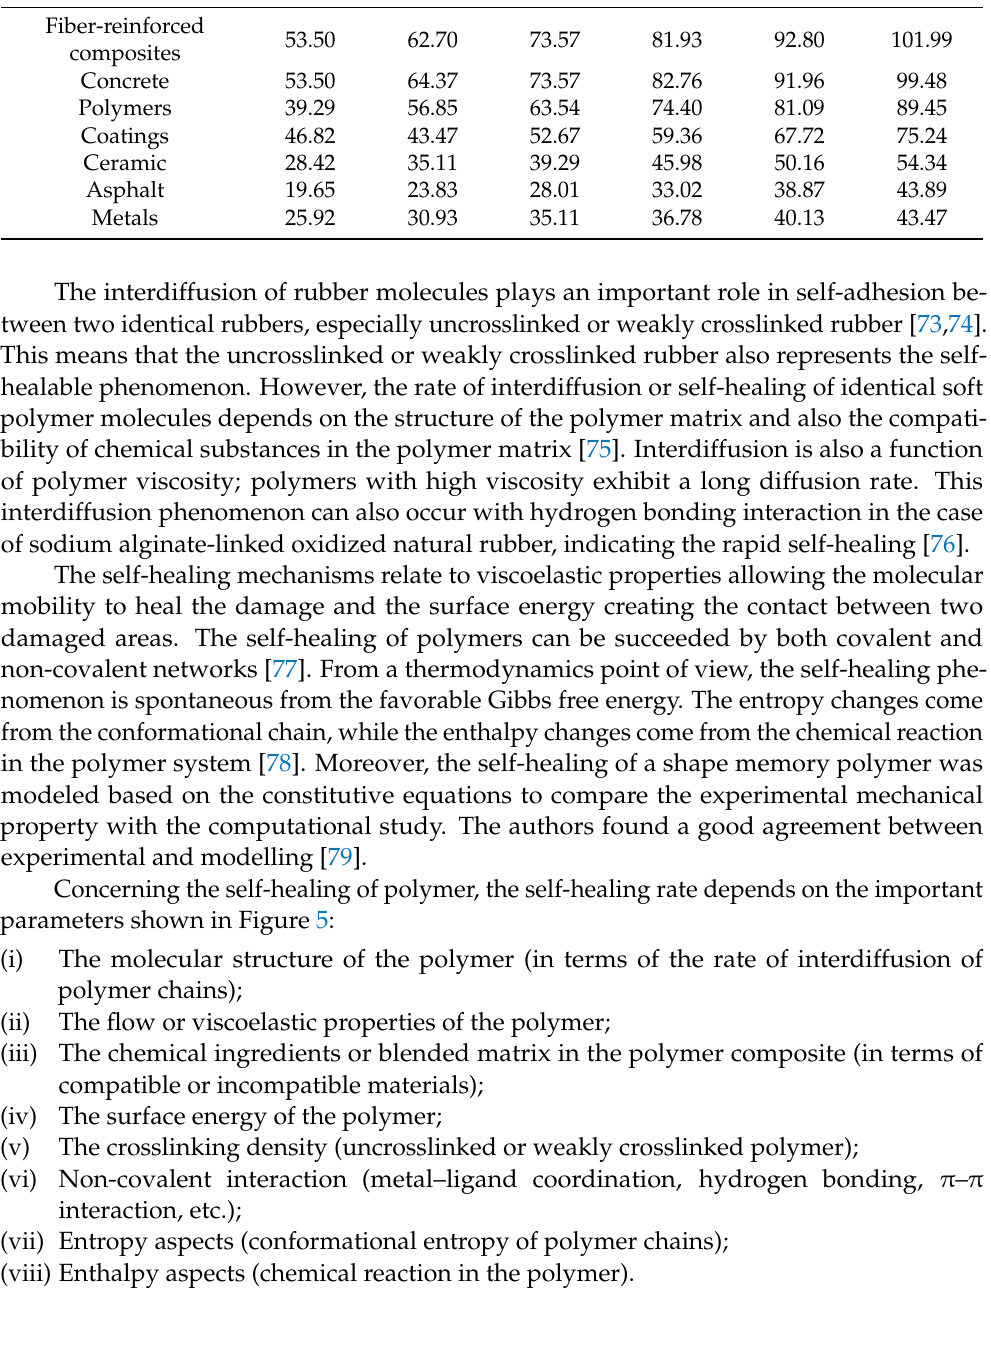
Table 1. Market revenue of self-healing materials in the USA from 2020 to 2025 (in USD millions) [72]. Market Revenue (in USD Type of Product